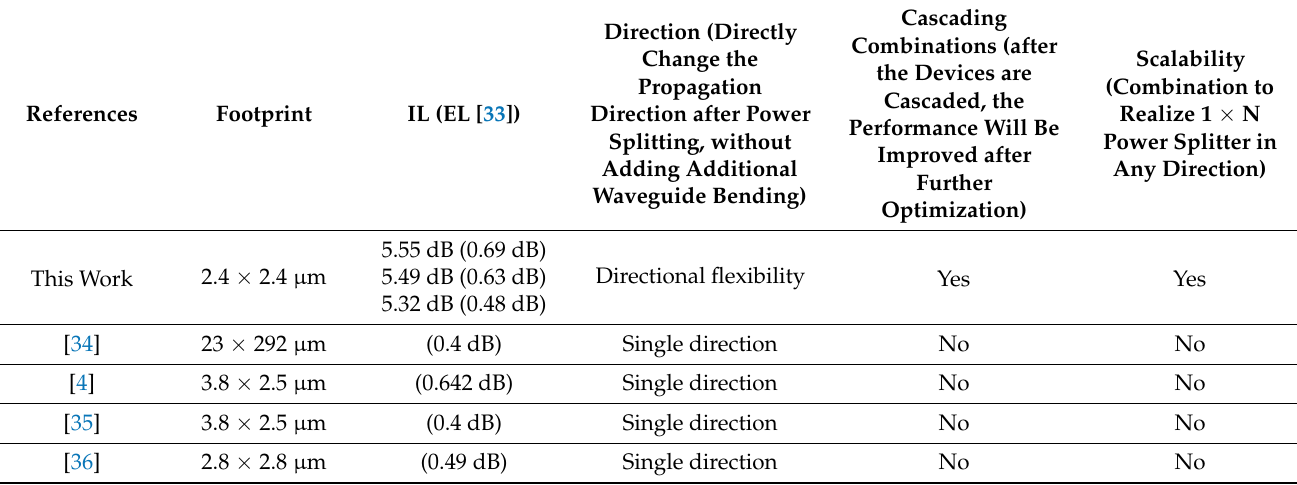
Table 1. Comparison of other works.